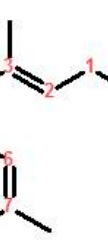
Figure 1. Chemical structure of